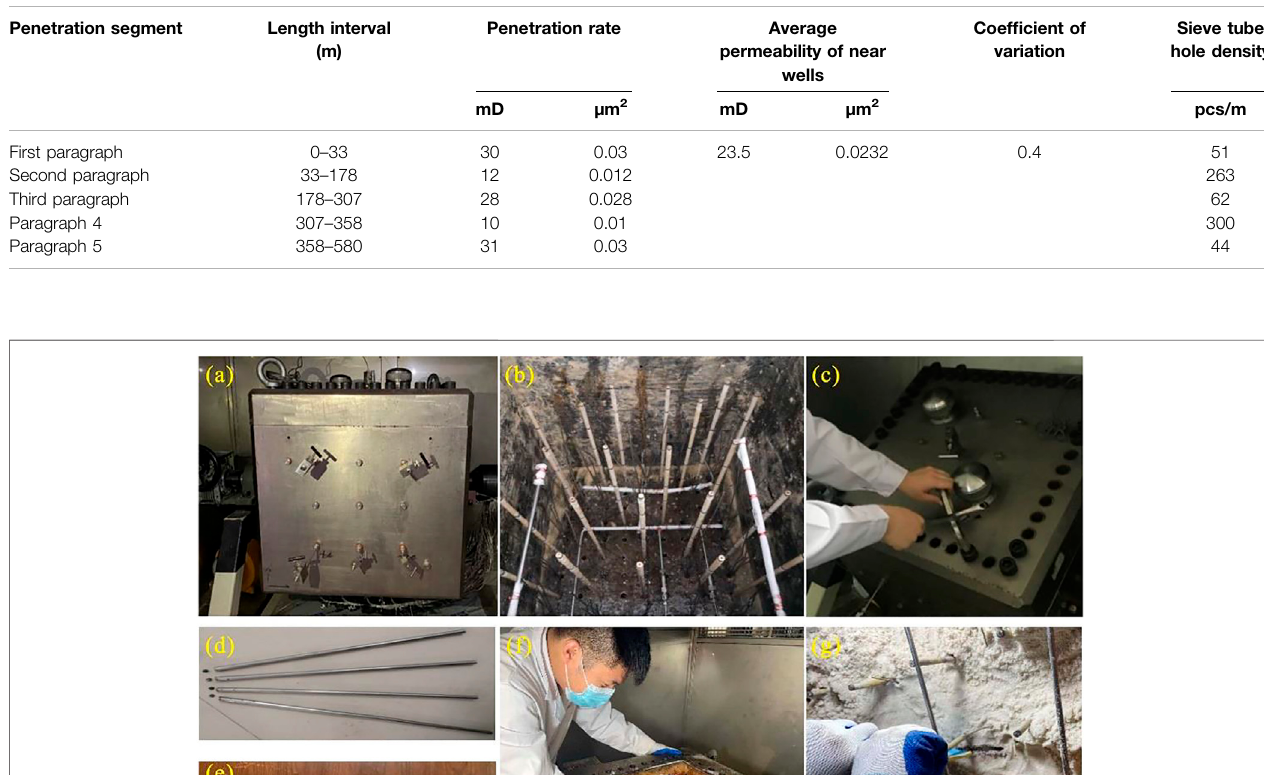
Frontiers in Earth Science |